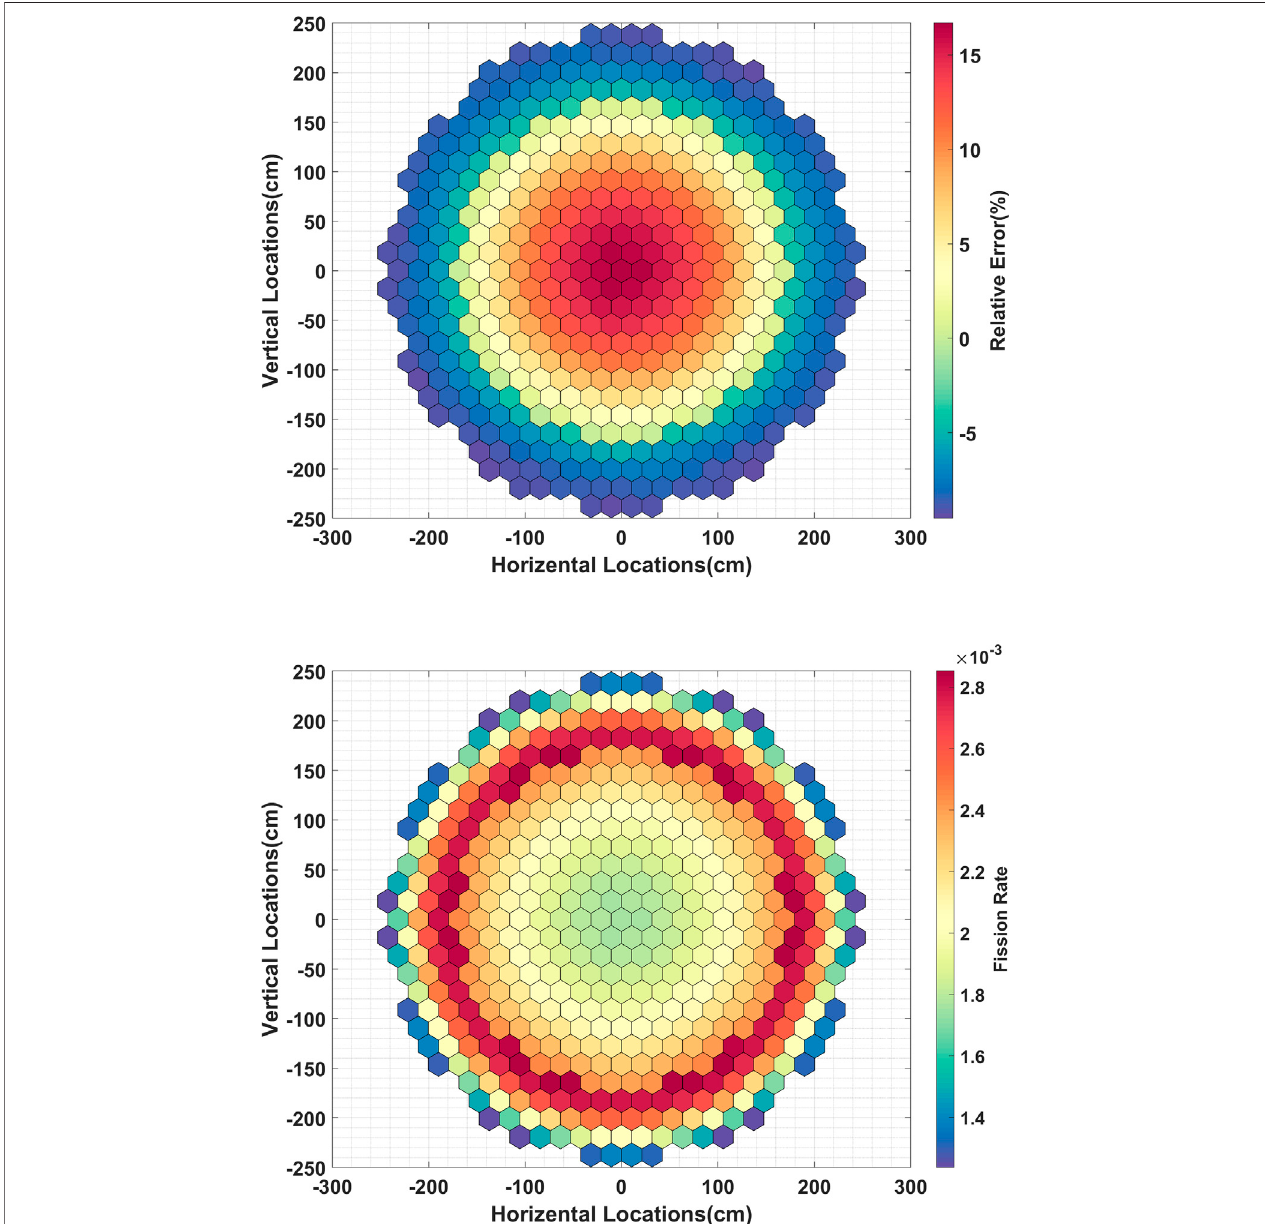
FIGURE 10 | The fi ssion rate from Monte Carlo calculation and its relative error with that from the combined fi ssion matrix theory.